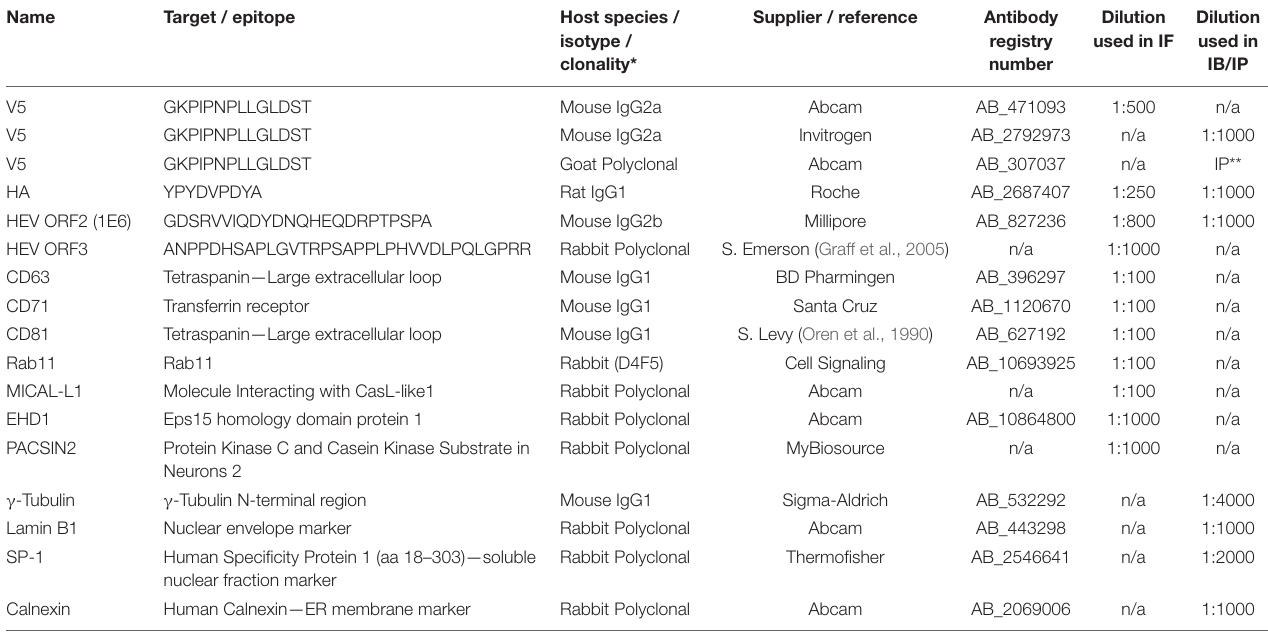
TABLE 2 | List of primary antibodies used in this